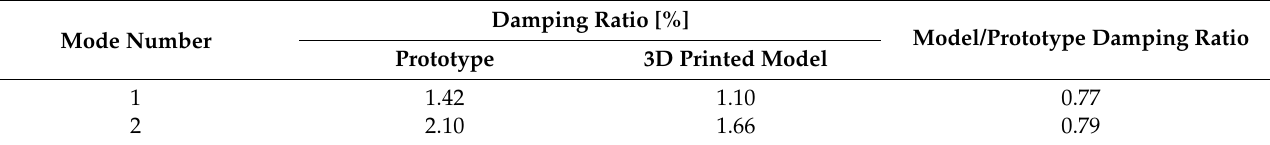
Table 7. Damping ratios estimated for the prototype from the field experiment and for the 3D printed polymer model from the shaking table test.